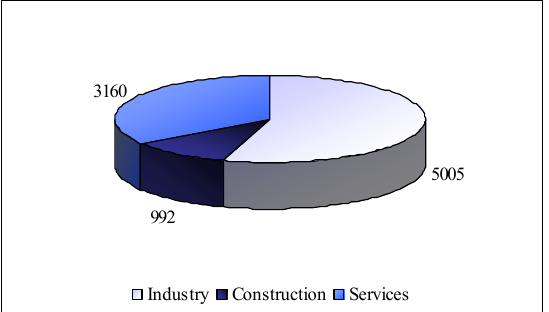
Figure 4 - The number of enterprises with innovation activity according to the sector of their operation in Czech